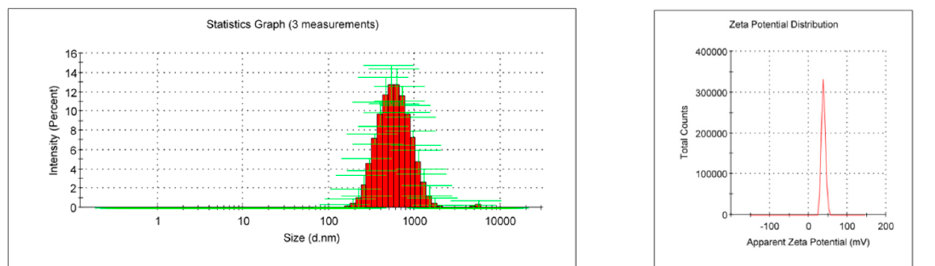
Figure 3. Size distribution and Zeta potential of chitosan Conjugate 2.